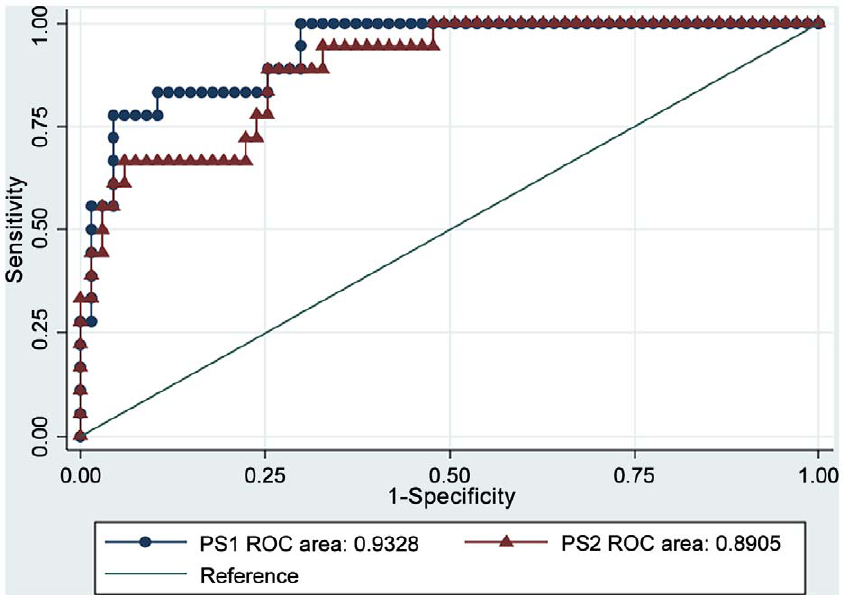
Figure 1. Receiver Operating Curve for the Prognostic Score 1 (PS1) and Prognostic Score 2 (PS2) of antimony chemotherapy treatment